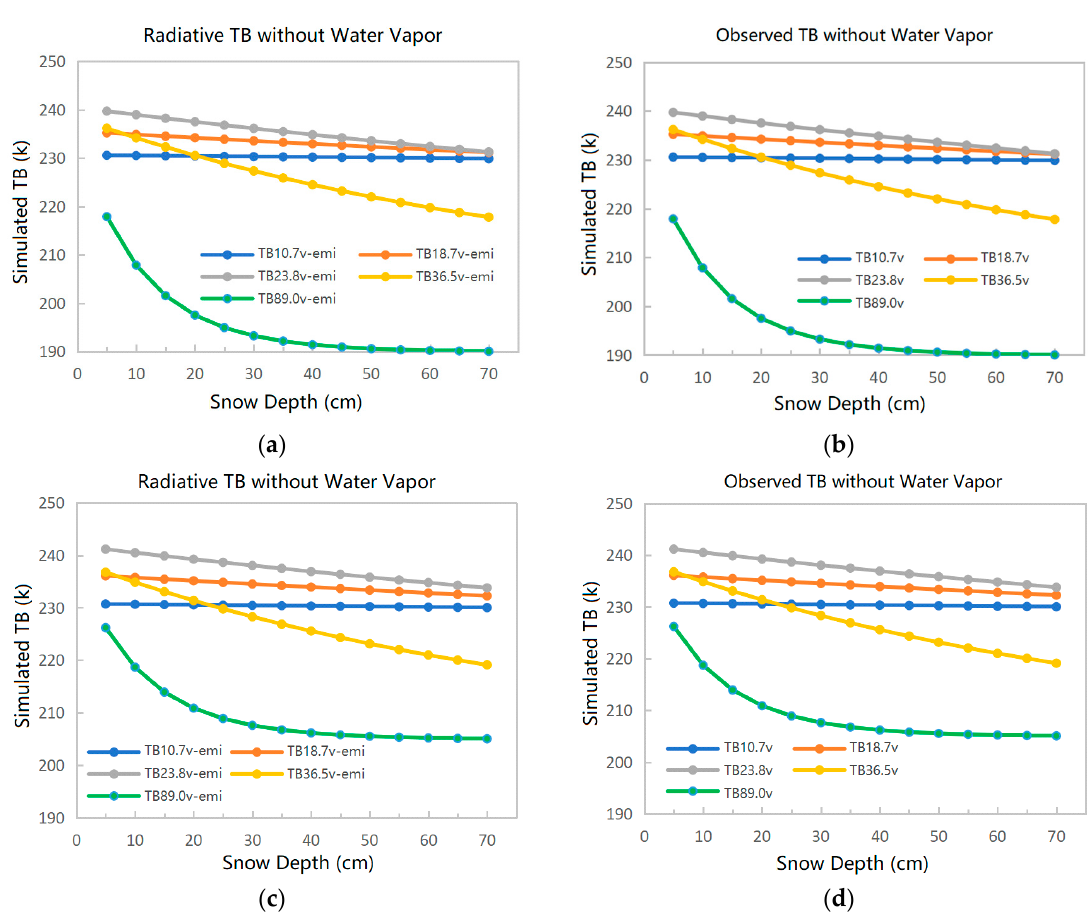
Figure 2. Variation of TB with snow depth. ( a ) Internal radiation from snow without water vapor; ( b ) observed TB without water vapor; ( c ) internal radiation from snow with water vapor; ( d ) observed TB with water vapor.